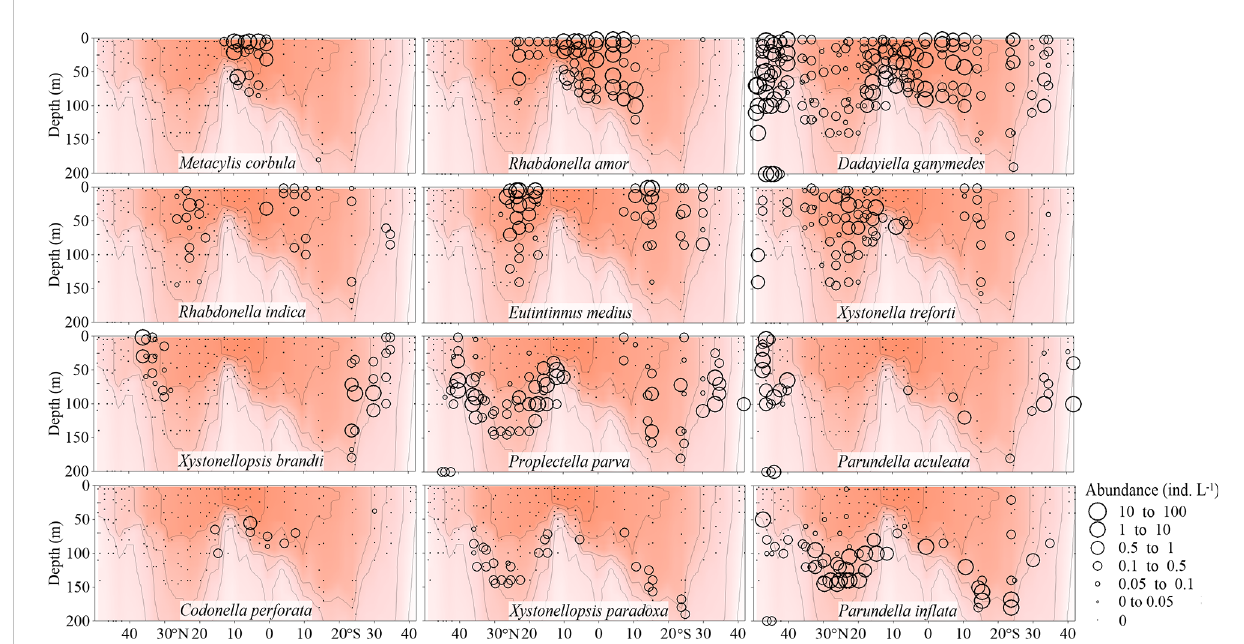
FIGURE 4 Vertical abundance (ind. L -1 ) distribution of typical Tintinnina species in each biogeographic region along the AMT transect: from top to bottom, equatorial species, gyre species, frontal species and Deep Chl a Maximum species. The red color and isothermal lines are temperature (°C) as in Figure 2. Black dots denote the locations of sample